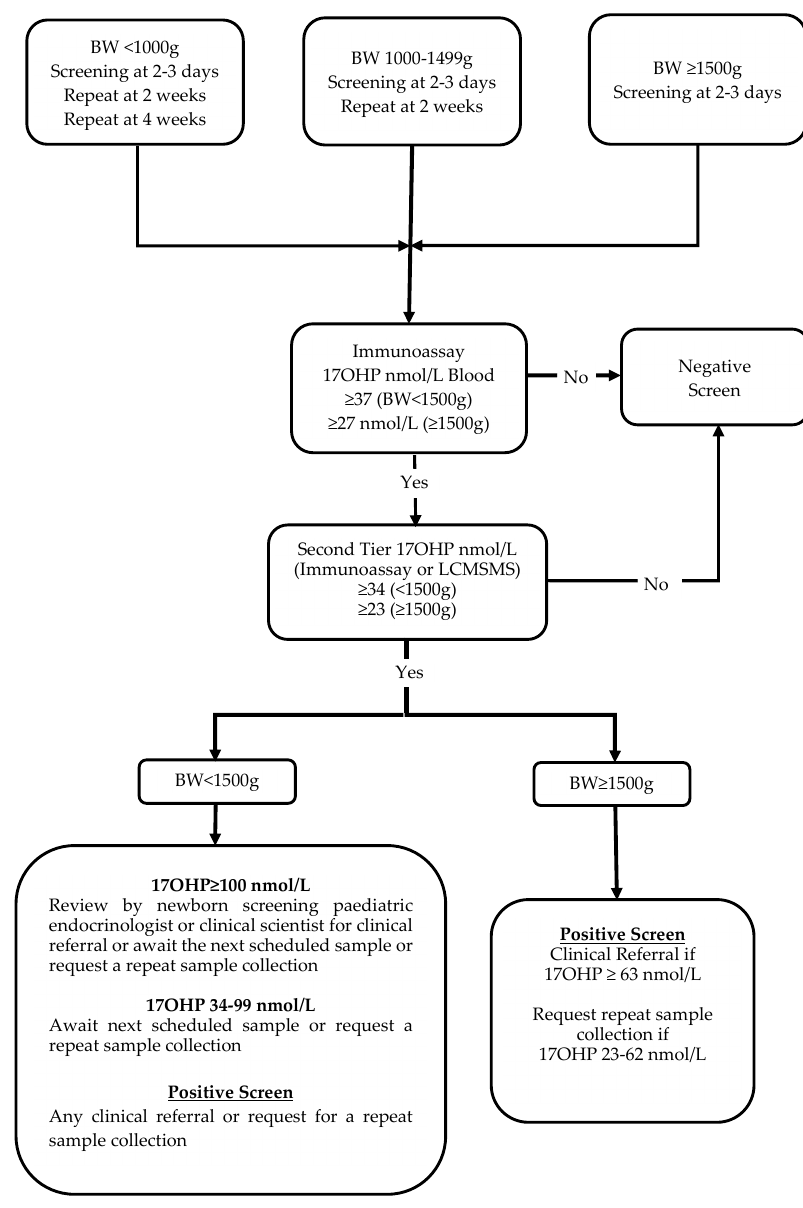
Figure 1. Flowchart of the original laboratory protocol (protocol 1) for NBS for congenital adrenal hyperplasia in New Zealand. Prior to 1 December 2017, second-tier 17OHP measurement was by immunoassay after solvent extraction and was subsequently replaced by